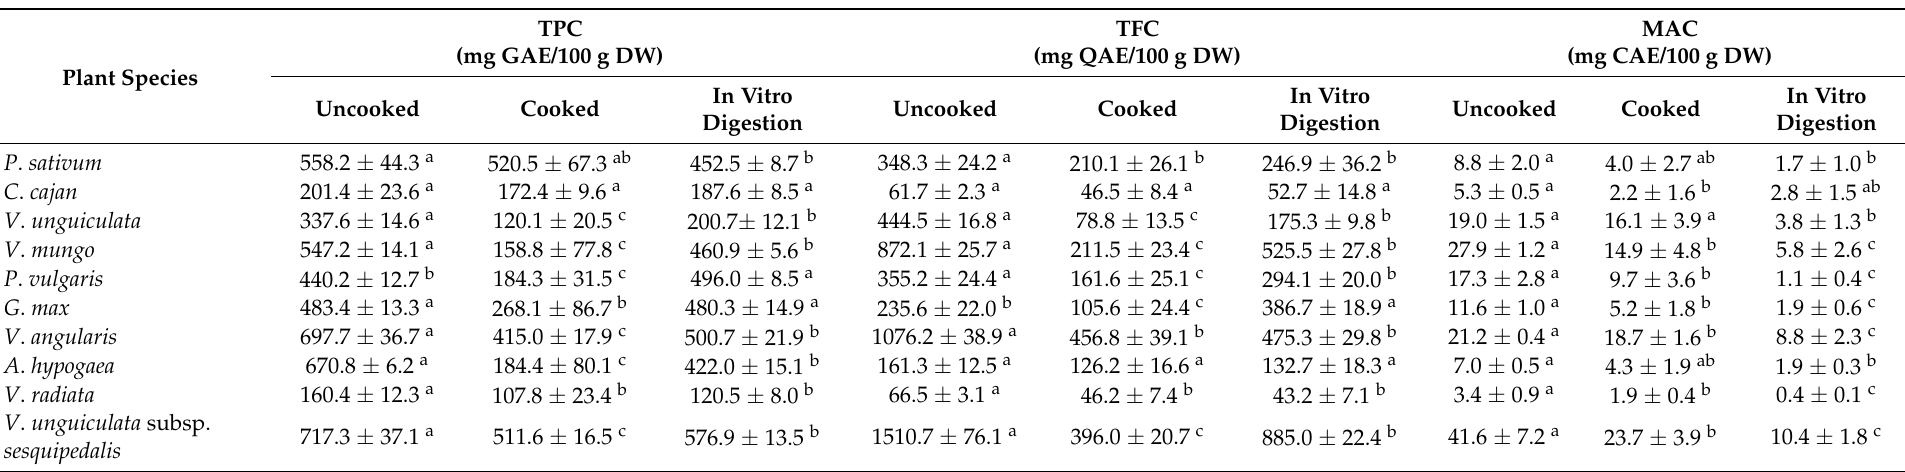
Different superscript letters indicate significant differences at p <